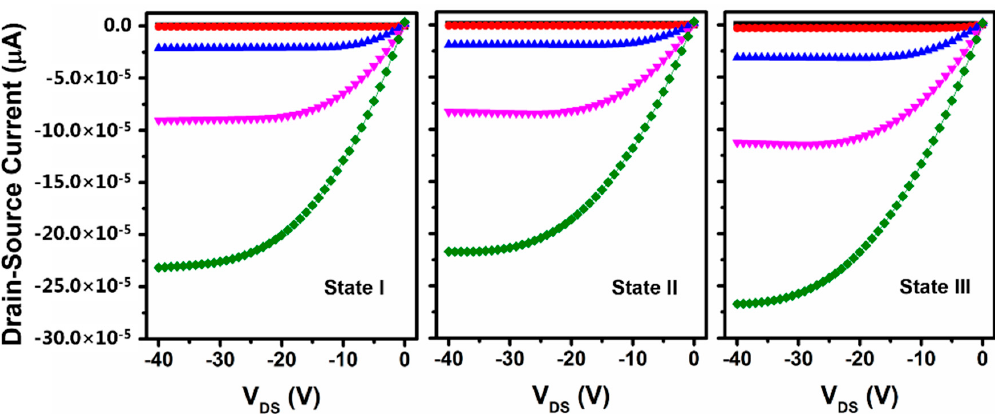
Figure 5. Output characteristics ( V G = 0 to − 40 V, with a − 10 V step) of pentacene-based OFETs with different gate biases and NH 3 concentrations. State I: gate bias was 0 V and no NH 3 ; State II: gate bias was 0 V and 10 ppm NH 3 ; State III: gate bias was − 40 V and 10 ppm NH 3 .